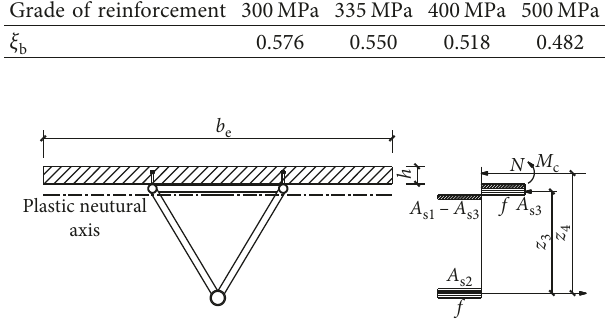
Figure 22: Sketches of the composite truss with the plastic neutral axis in the steel truss.